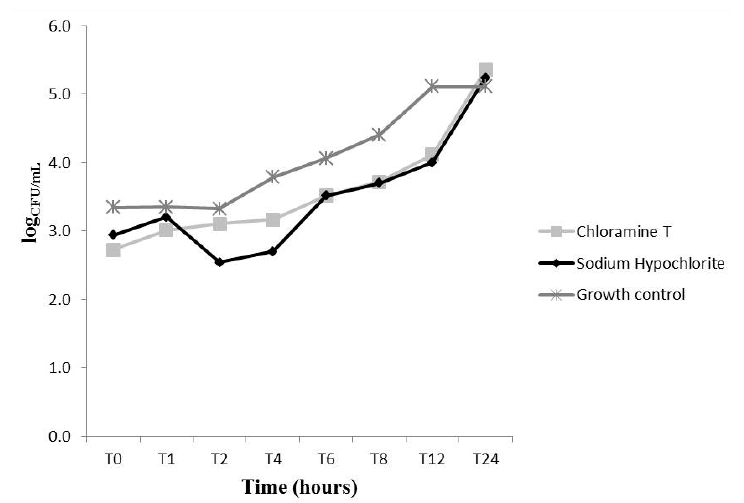
Figure 2. Candida albicans ATCC 60193 fungal growth kinetics upon treatment with chloramine T (2.77 mmol/L) and sodium hypochlorite (8.39 mmol/L) at their MIC concentrations.